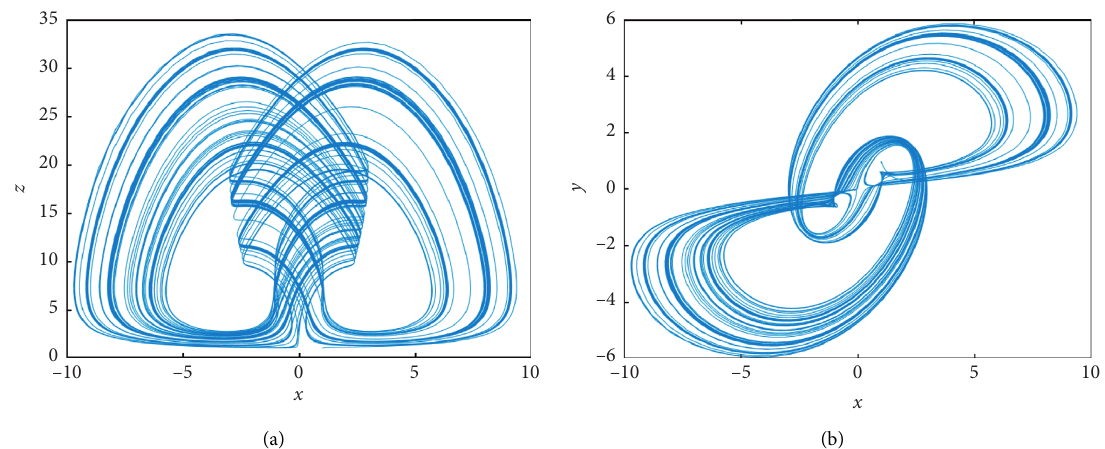
Figure 11: Phase portraits of the fractional system with a � 3 . 5 and α � 0 . 95.